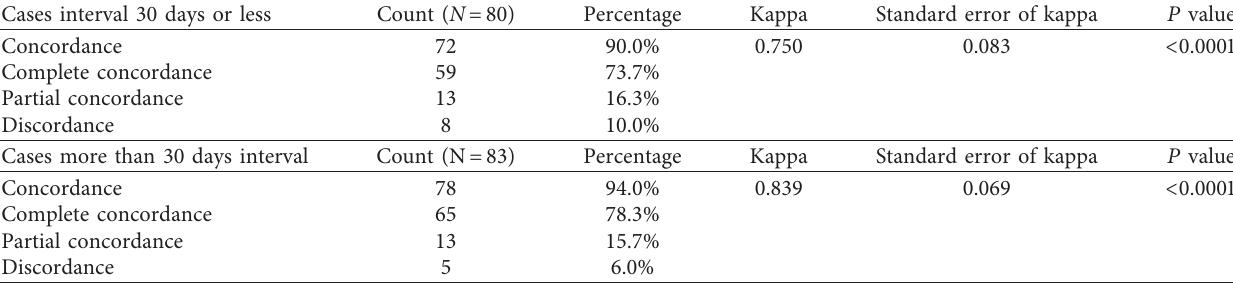
Table 2: Correlation of peripheral blood NGS and bone marrow NGS.